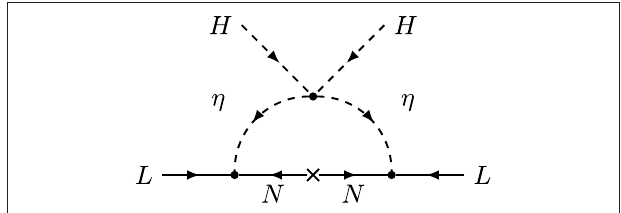
FIGURE 20 | 1-loop neutrino masses generated in the scotogenic